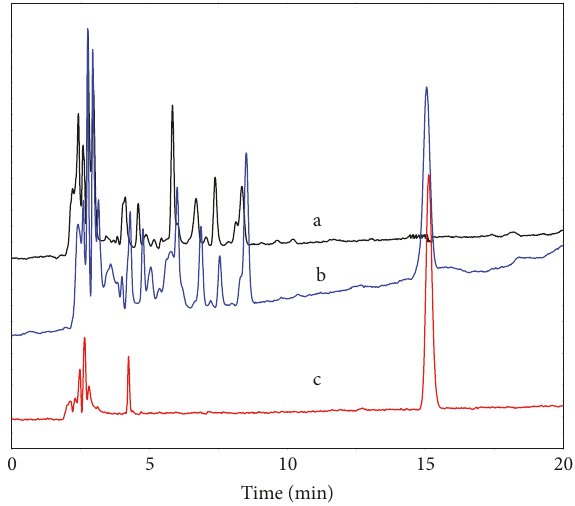
Figure 9: Chromatograms of blank soybean sample (a), soybean samplespikedwithTBM(0.045 𝜇 g/kg)(b),andthestandardsolution of TBM